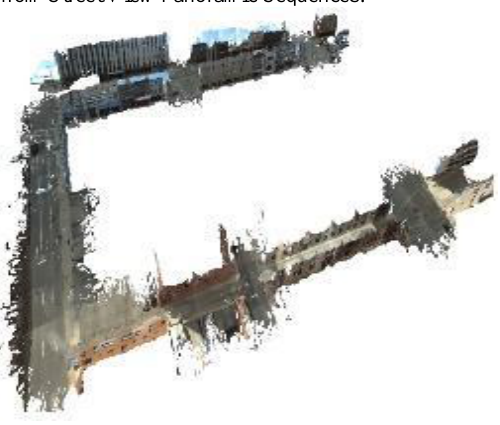
Fig.6- City model reconstruction from car image